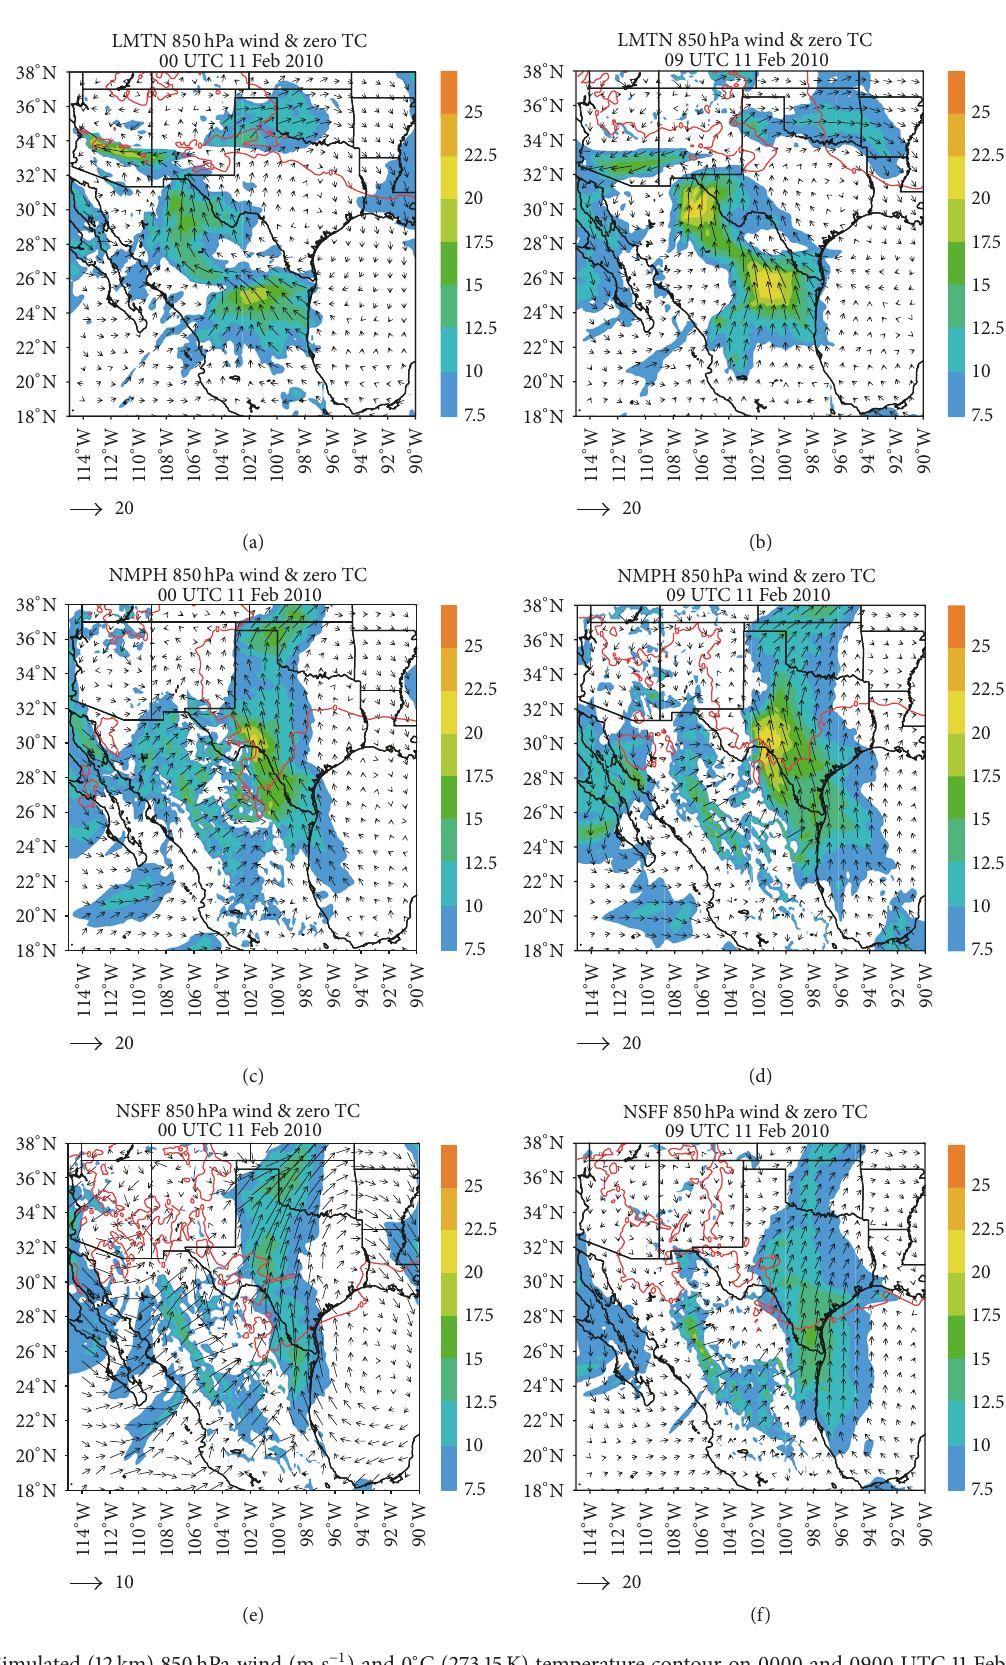
Figure 18: Simulated (12km) 850 hPa wind (m s −1 ) and 0 ∘ C (273.15 K) temperature contour on 0000 and 0900 UTC 11 February 2010 for (a-b) terrain reduction experiment, (c-d) no microphysics heating experiment, and (e-f) no surface flux